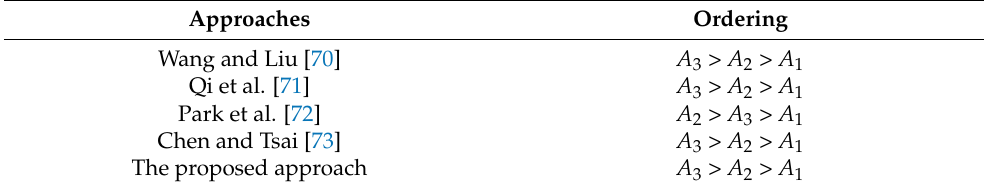
Table 6. Results of the Comparative Study.